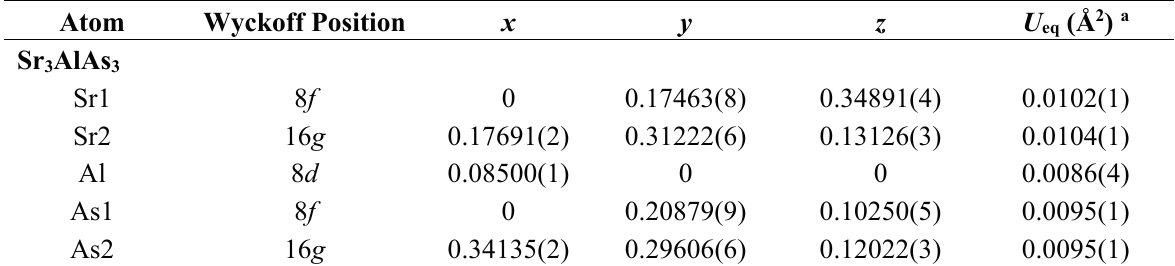
Table 2. Positional and equivalent isotropic displacement parameters for AE 3 AlAs 3 ( AE = Sr,